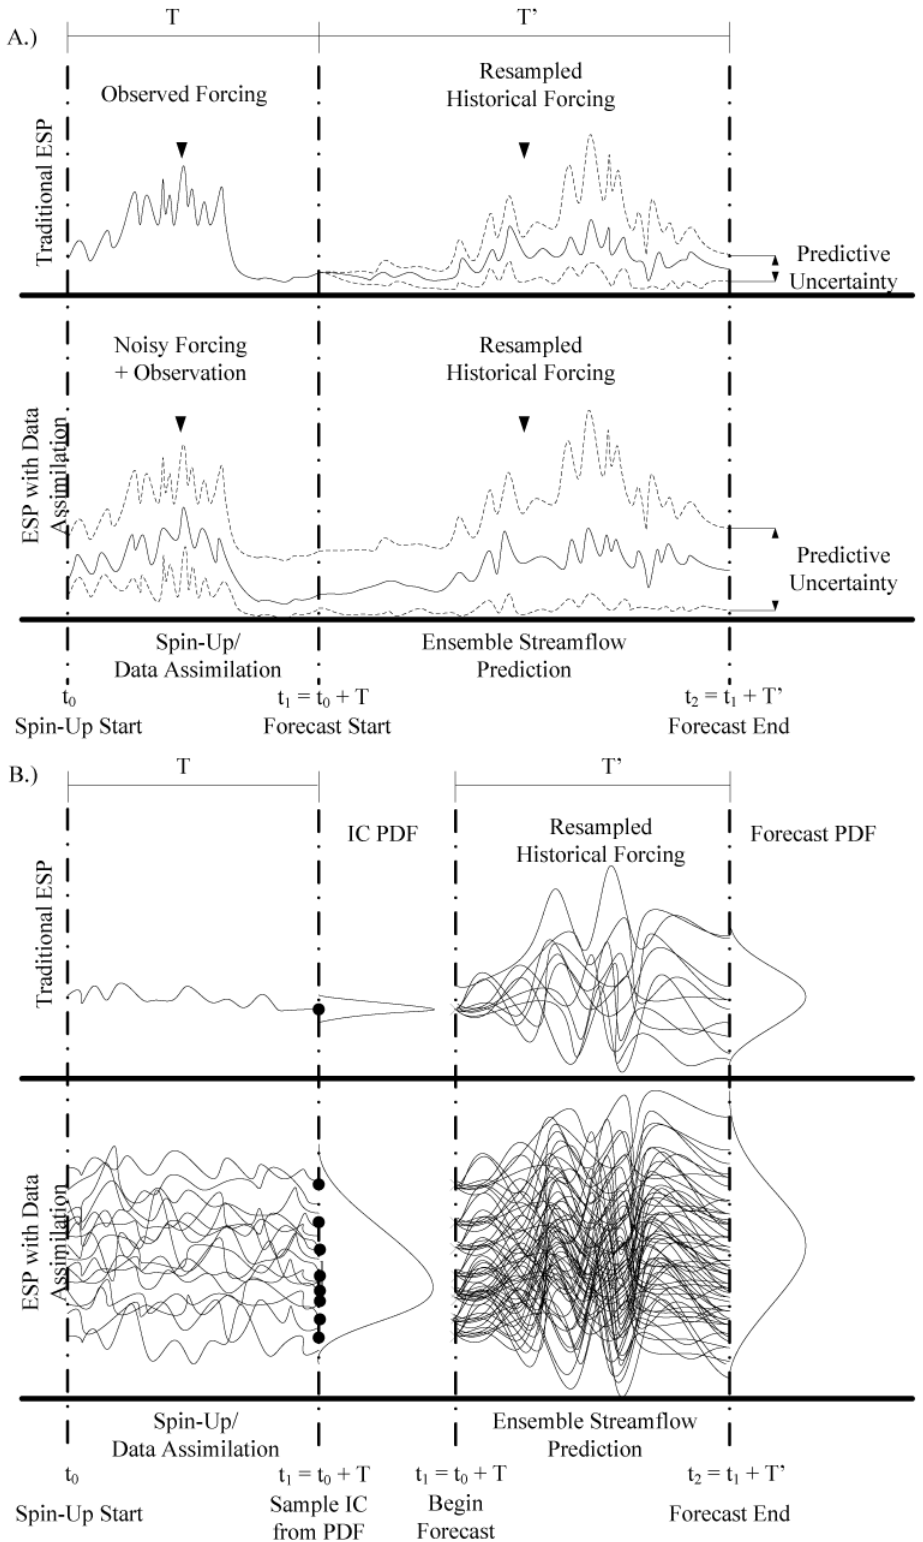
Fig. 4. Diagram of the ESP and ESP-DA algorithms. (a) shows the uncertainty bounds of the data assimilation and forecast, (b) shows the individual traces generated from each